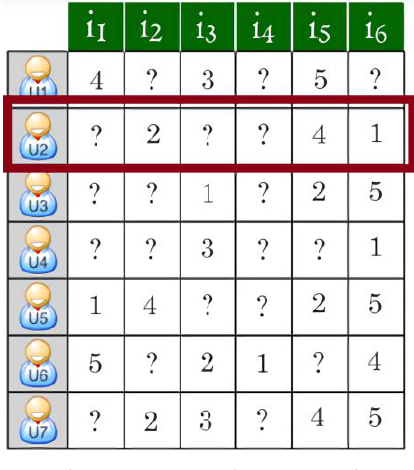
Figure 2. Users and Items